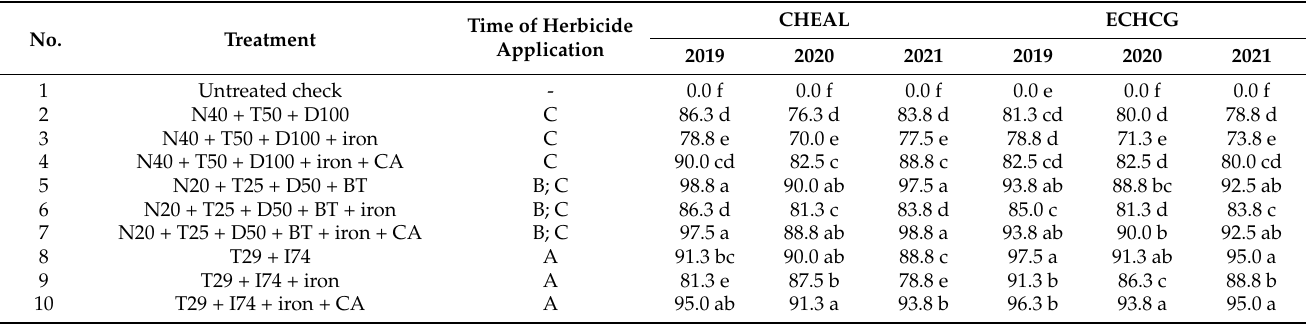
Table 6. Visual assessment of the Chenopodium album (CHEAL) and Echinochloa crus-galli (ECHCG) control